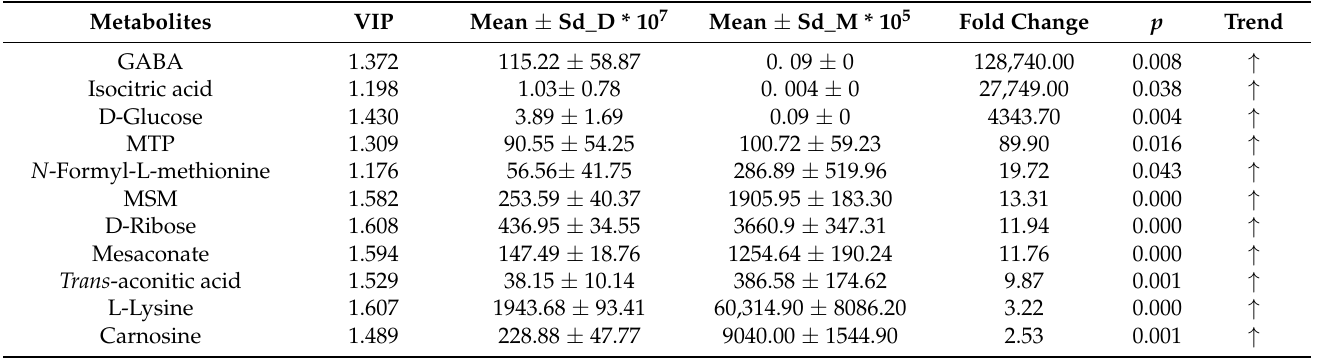
Table 1. The key nitrite-degrading compounds screened from the L. fermentum RC4 fermenta- tion broth.